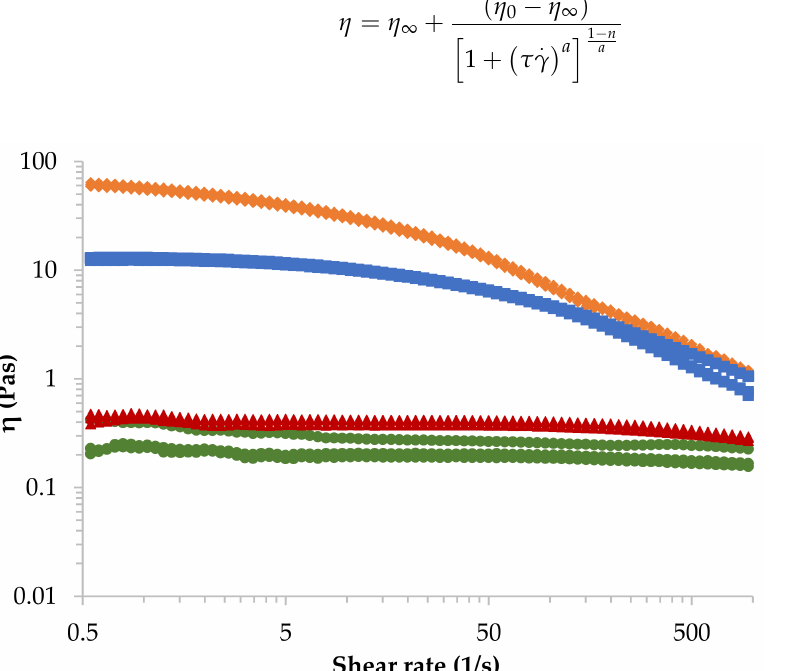
Figure 1. Shear-viscosity of four sodium alginate aqueous solutions at a concentration of 4% ( w / w ) and 23 ◦ C; LoG 495 (rhomb), HiG 427 (square), InG 253 (triangle), and LoG 187 (sphere) ( n = 3 per group). Dynamic shear tests (time sweep experiments) were performed for the determination of storage modulus (G’) of each alginate gel at different concentrations using parallel plates (20 mm, aluminium serrated, F n 2 and 5 N) at 23 ◦ C. Time varied from 0 to 300 s applying a frequency of 1 Hz and a constant deformation in the linear viscoelastic regime (0.01%). All measurements were performed three times to facilitate statistical